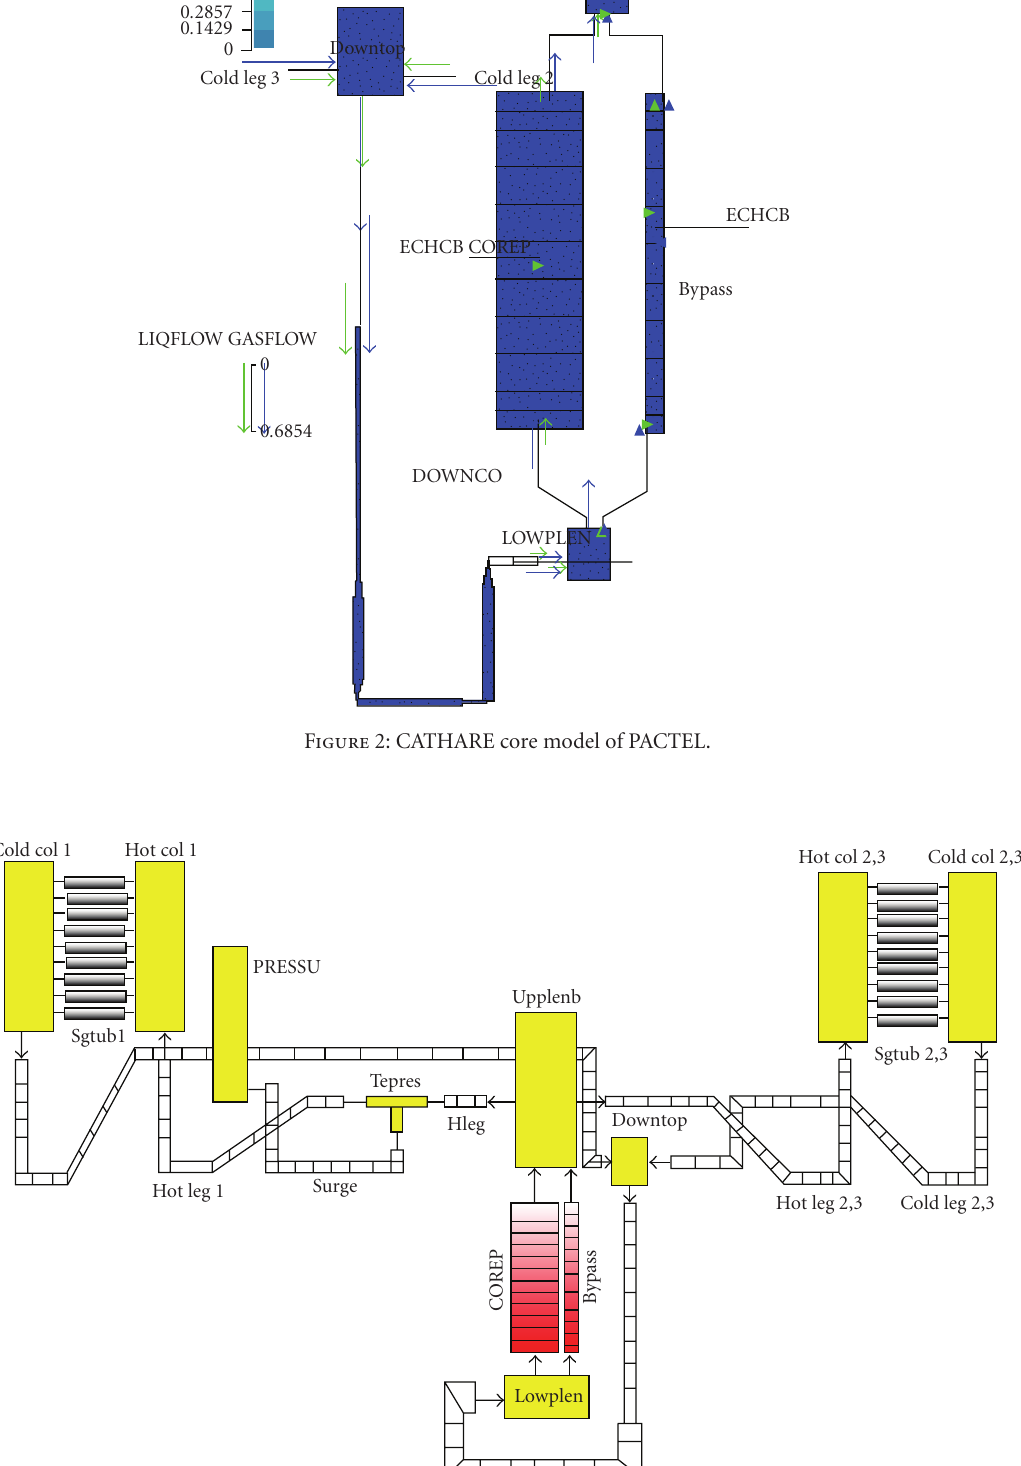
Figure 3: CATHARE nodalization of the PACTEL primary